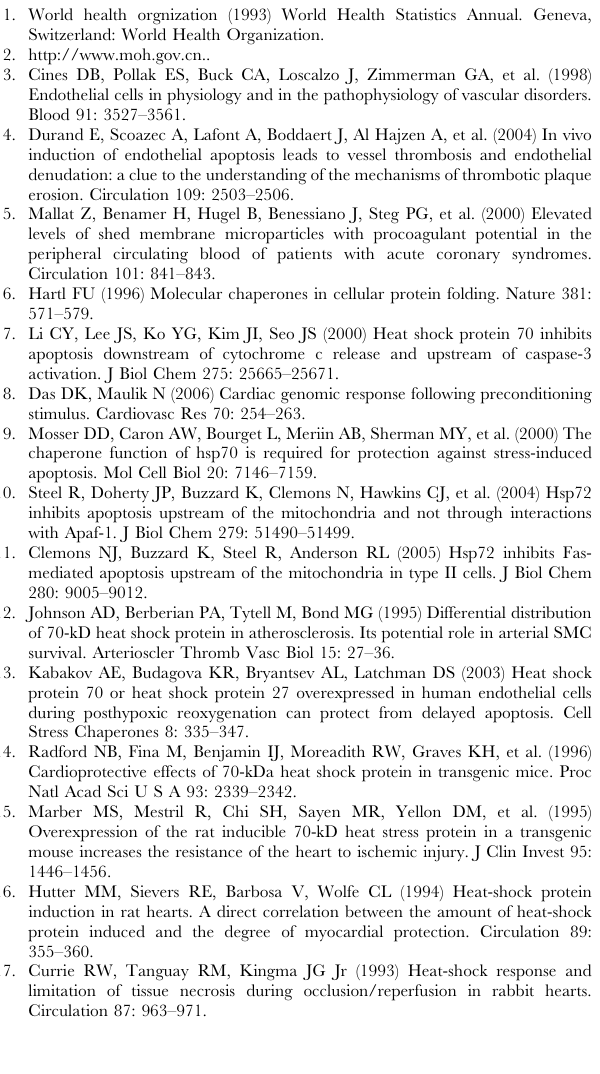
Found at: doi:10.1371/journal.pone.0004851.s002 (0.03 MB